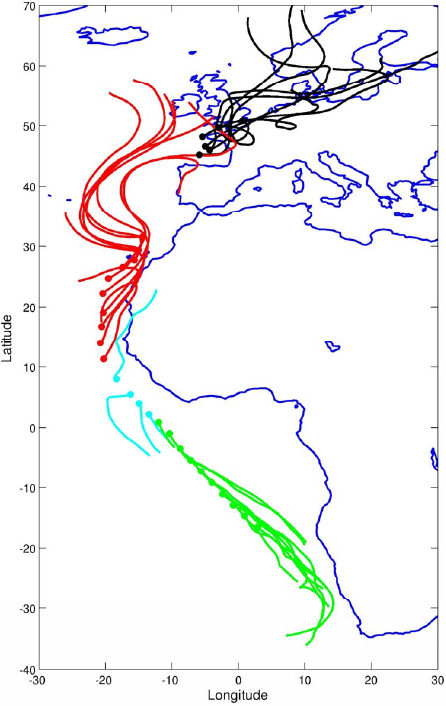
Fig. 1. Five-day HYSPLIT back trajectories initiated at 500-m ele- vation along the cruise track. Start times correspond to the midpoint of each aerosol and filter-pack sampling interval. Trajectories for the EURO regime are plotted in black, N-AFR in red, ITCZ in light blue, and S-ATL in